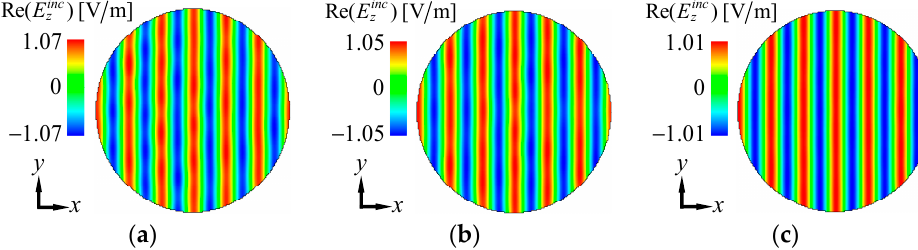
Figure 5. Extraction results of incident wave in Ω i (target is cylinder): ( a ) M = 51, ( b ) M = 100, and ( c ) M = 200.